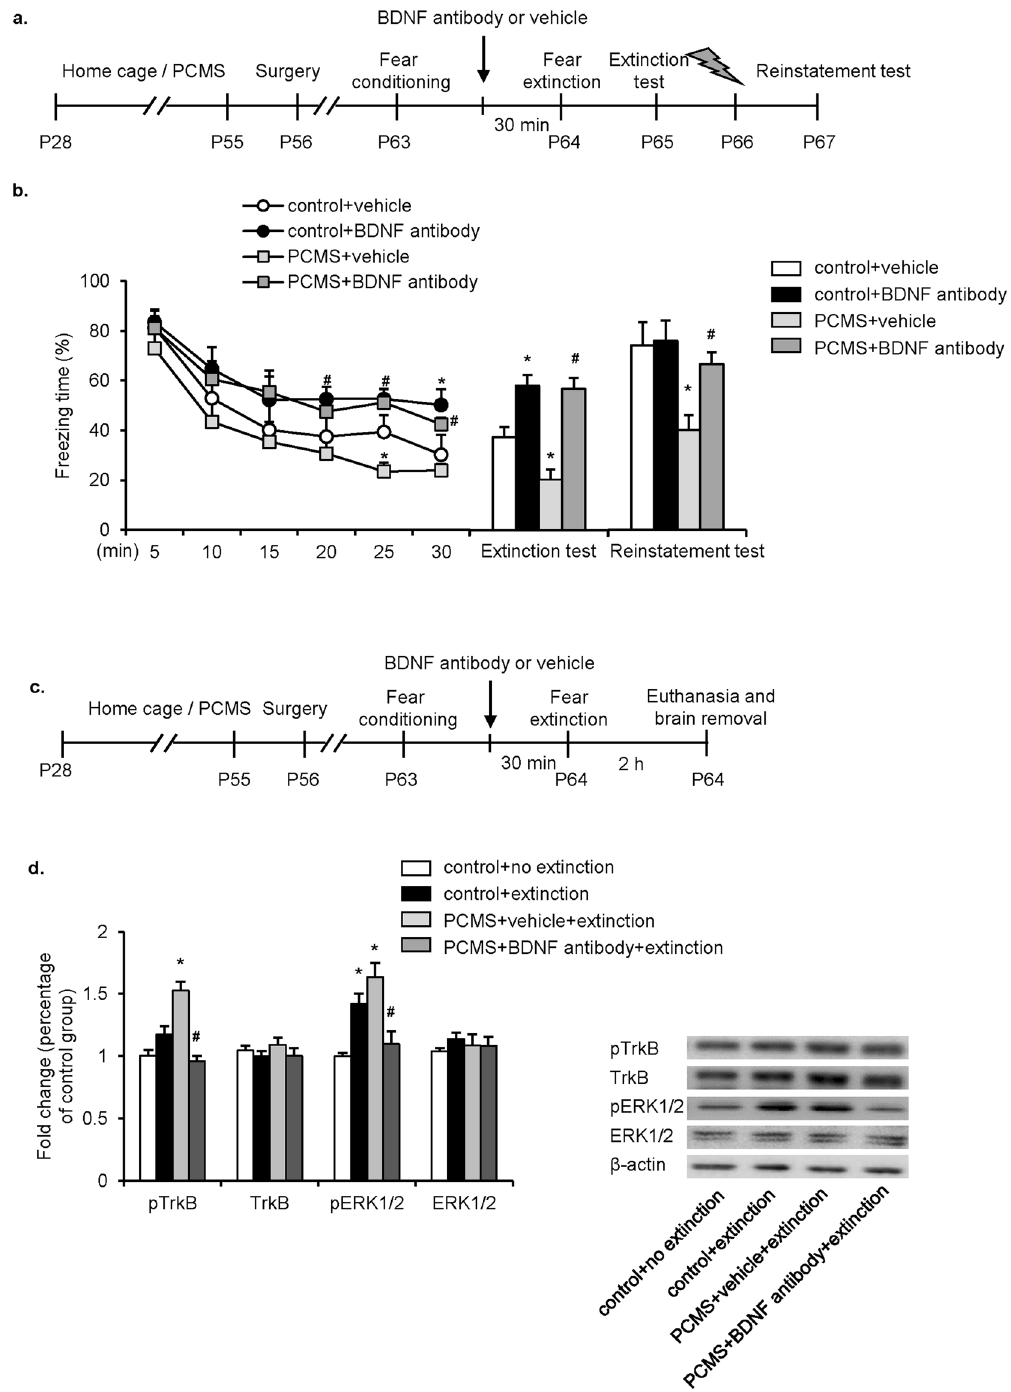
Figure 4. Intra-IL infusion of BDNF antibody reversed the PCMS-induced enhancement of fear extinction. ( a , c ) Experimental timeline. ( b ) Intra-IL infusion of BDNF antibody (0.5 μ g/0.5 μ l per side) blocked the enhancement of extinction and decrease in reinstatement induced by PCMS. The data are expressed as the mean ± SEM ( n = 8–10 per group). * p < 0.05, compared with control + vehicle group; # p < 0.05, compared with PCMS + vehicle group. ( d ) Protein levels and representative western blot bands of pTrkB, TrkB, pERK1/2, and ERK1/2 in the IL after BDNF antibody infusion. Blots shown are cropped from full-length. The data are expressed as the mean ± SEM ( n = 6–8 per group). * p < 0.05, compared with control + no extinction group; # p < 0.05, compared with PCMS + vehicle + extinction